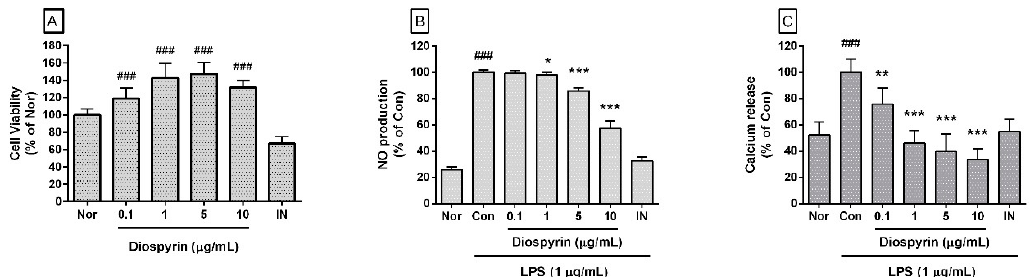
Figure 2. E ff ect of diospyrin on cell viability, NO production, and calcium release in lipopolysaccharide (LPS)-induced RAW 264.7 cells. After 24 h treatment, cell viability ( A ) was evaluated via a modified MTT assay and nitric oxide (NO) production ( B ) was measured using the Griess reaction assay. Calcium release ( C ) was measured with Fluo-4 calcium assay after 18 h treatment. Data are of mean ± SD and pooled from more than three independent experiments. Nor, normal group (media only); Con, control group (LPS alone); IN, indomethacin (0.5 µ M). ### p < 0.001 vs. Nor; * p < 0.05 vs. Con; ** p < 0.01 vs. Con; *** p < 0.001 vs. Con.